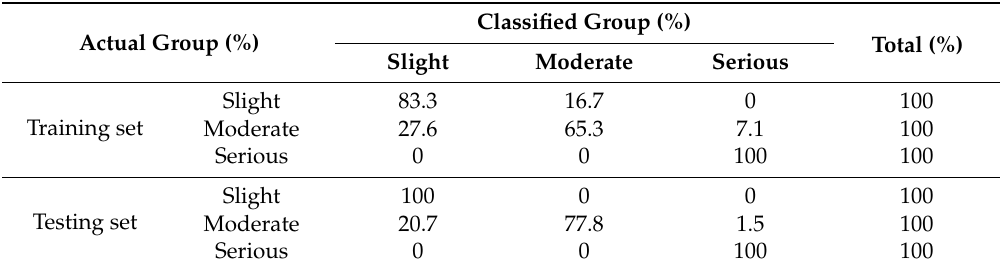
Table 3. Classification results for damage degree of mango performing discriminate analysis (DA) on spectral data according to